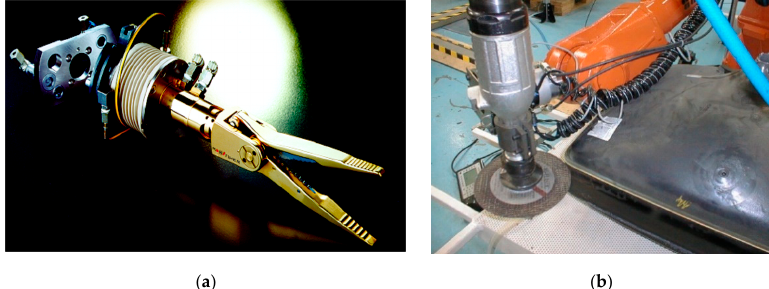
Figure 3. Specific tools for disassembly. ( a ) Pneumatic cutting tool with shock absorber; ( b ) Electric cutting